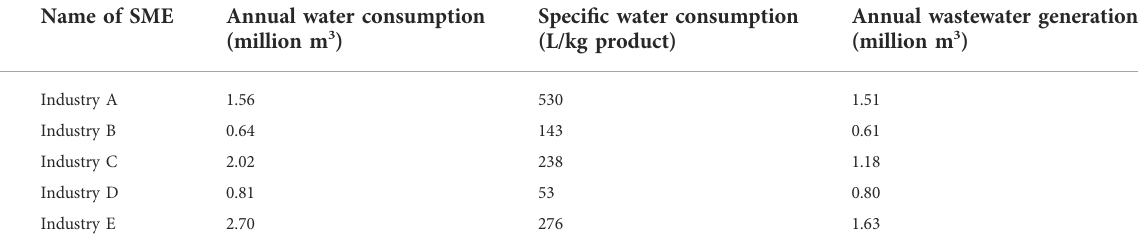
TABLE 3 Water consumption in studied industries.